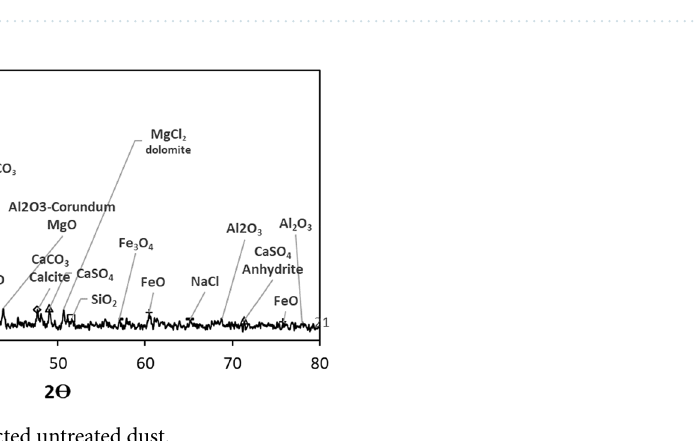
Figure 2. SEM images of dust particles: ( a ) dust particles with different shapes, and ( b ) small dust particles adhere on large particle surface.